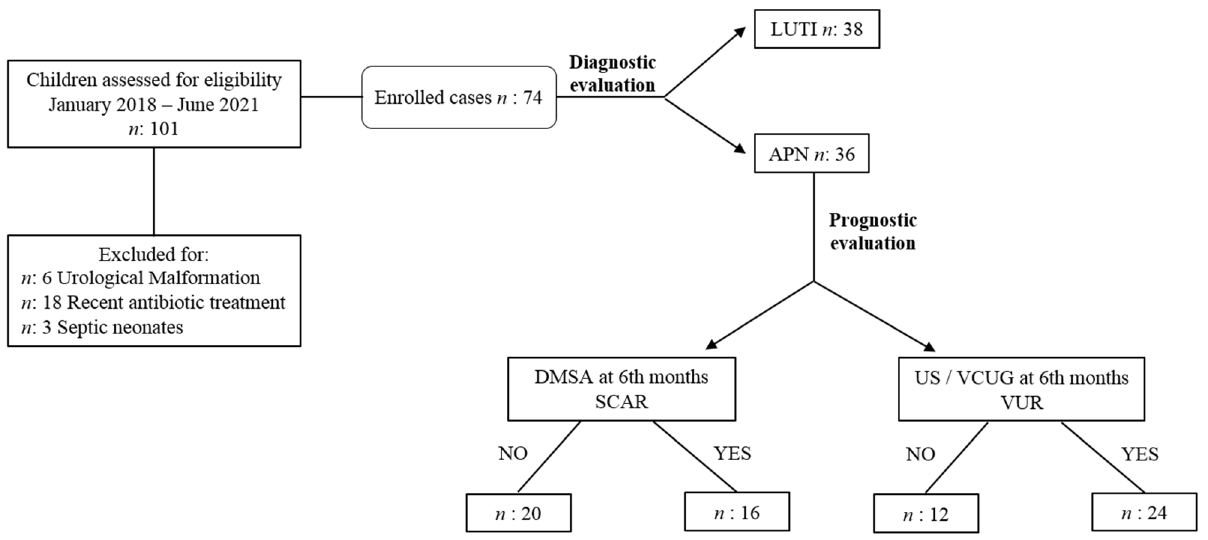
Figure 1. Study design. Abbreviations: LUTI: lower urinary tract infection; APN: APN: acute pyelonephritis; DMSA: technetium 99 mTC-dimercaptosuccinic acid renal scintigraphy; US/VCUG: ultrasound/ voiding cystourethrography; VUR: vesicoureteral